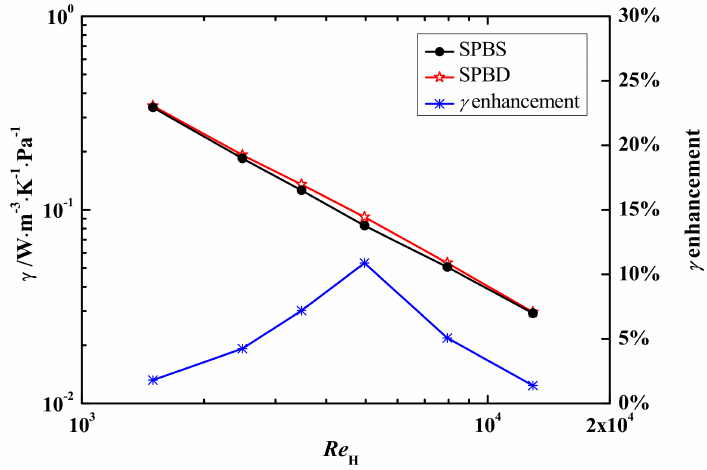
Figure 12. The overall heat transfer efficiency of the structured packed bed with smooth or dimpled spheres at N =